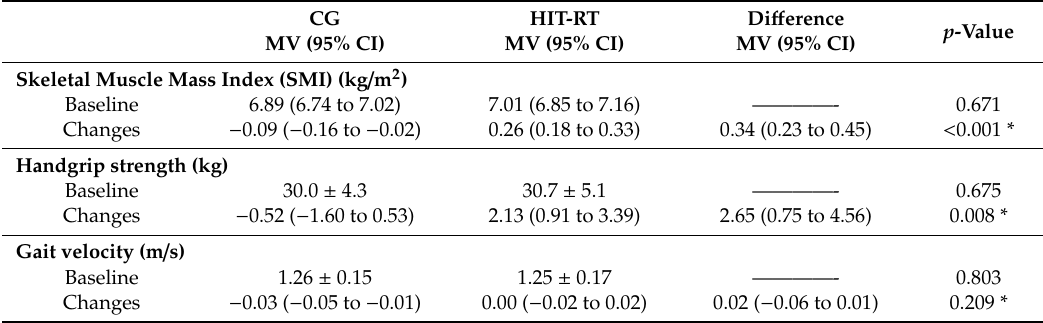
Table 3. Baseline data and changes in secondary (explanatory) study endpoints in the high intensity resistance exercise training group (HIT-RT) versus the control groups (CG). MV (95%-CI): mean value (95%-confidence interval). * unadjusted p